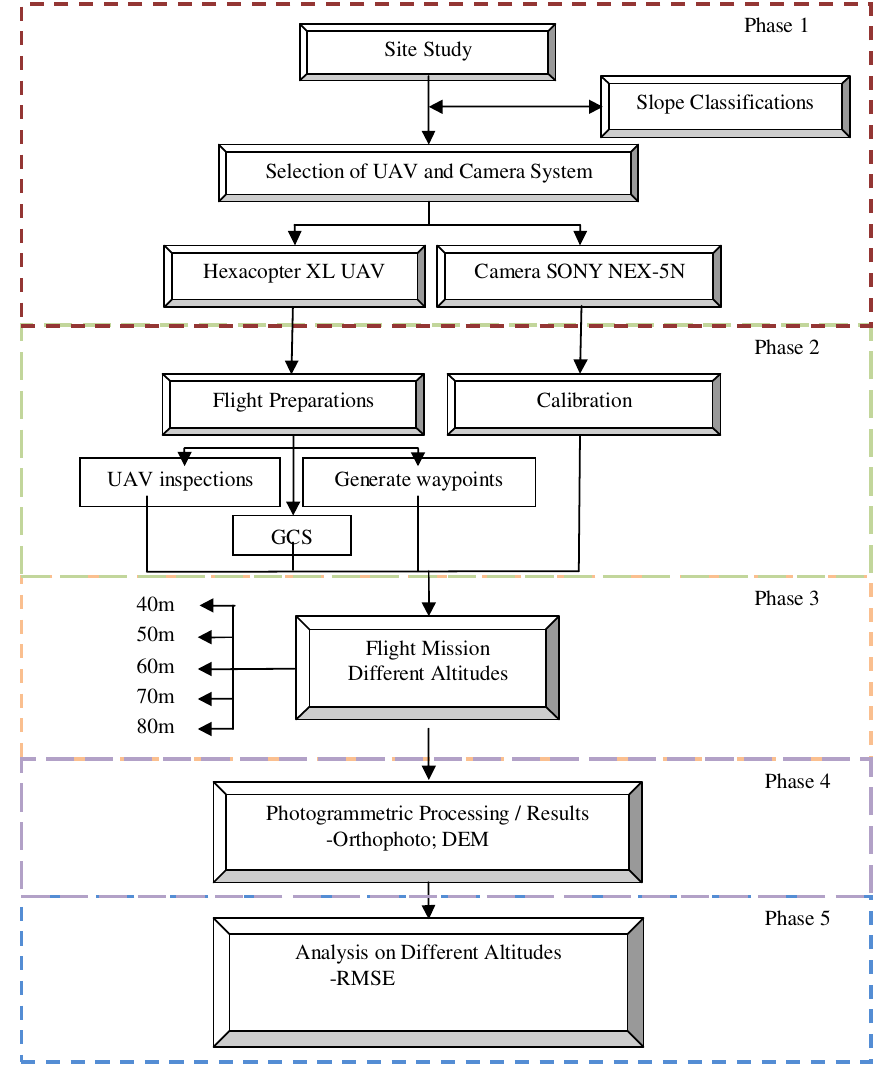
Figure 1. Research Methodology